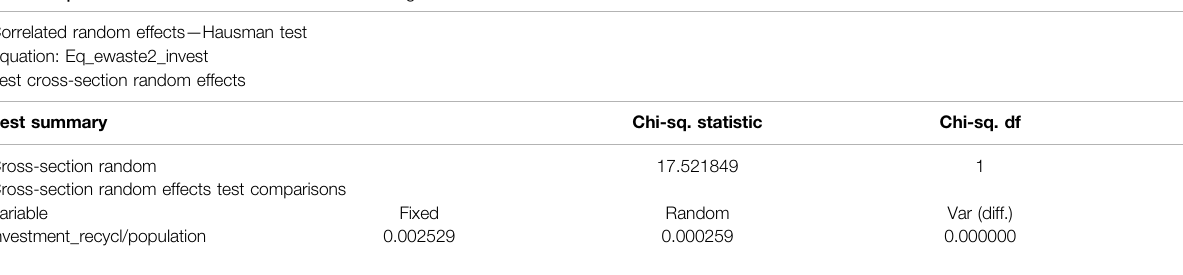
TABLE 4 | Hausman test / Source: Own calculation using EViews